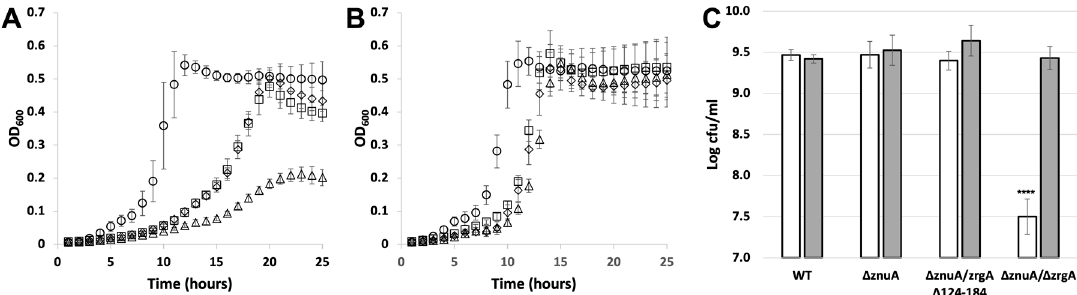
Figure 2. Growth and survival of WT and mutant V. cholerae . Growth curves for WT (circles), Δ znuA (squares), Δ znuA/zrgA Δ 124-184 (diamonds), Δ znuA/ Δ zrgA (triangles) in the absence of zinc ( A ) or in the presence of 50 μ M ZnCl 2 ( B ). Data are representative of 3 replicate experiments. Error bars represent standard deviations for 9 replicate wells. ( C ) Colony forming units (CFU) for strains grown for 24 h under zinc-free (white bars) and 50 μ M ZnCl 2 (gray bars) conditions. Error bars represent standard deviations for 3 replicate plating experiments. A two-way ANOVA followed by Tukey’s multiple comparison test demonstrates that viability in the Δ znuA/ Δ zrgA strain under zinc-deficient conditions was significantly decreased relative to all other strains and conditions, **** p < 0.0001.